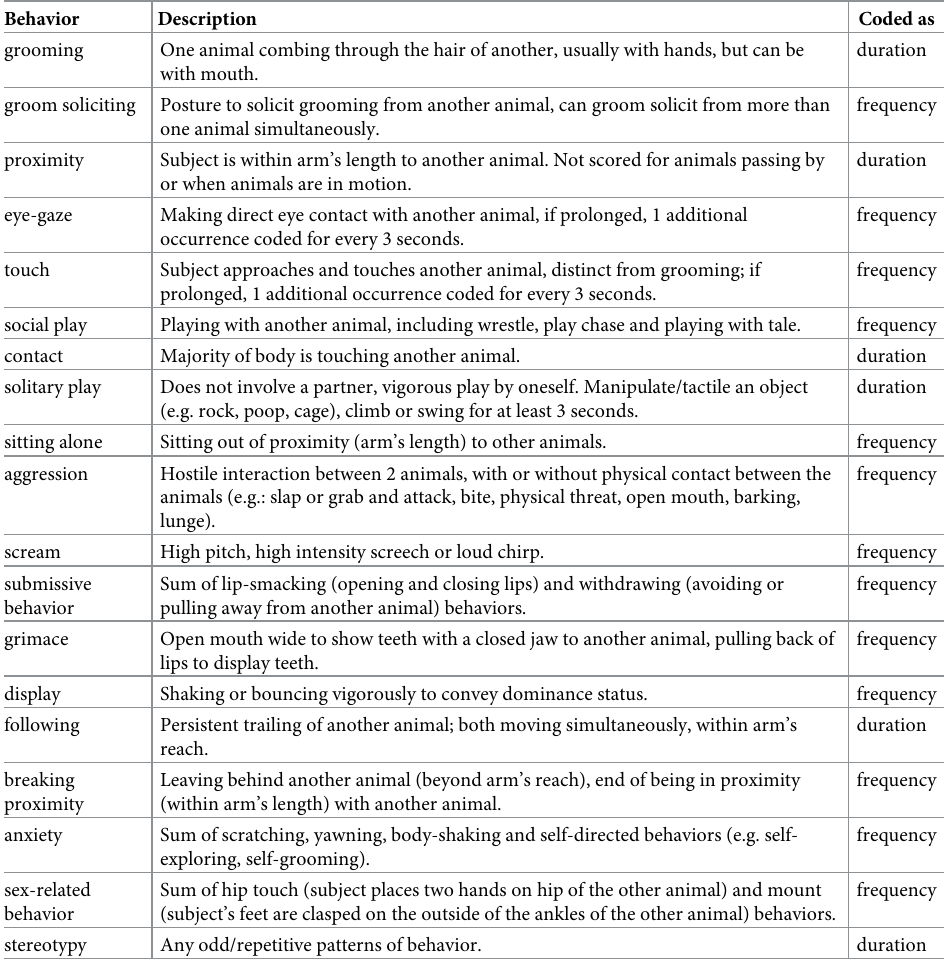
Table 1. List of behaviors coded during the behavioral observations (ethogram). Behavior Description Coded as grooming